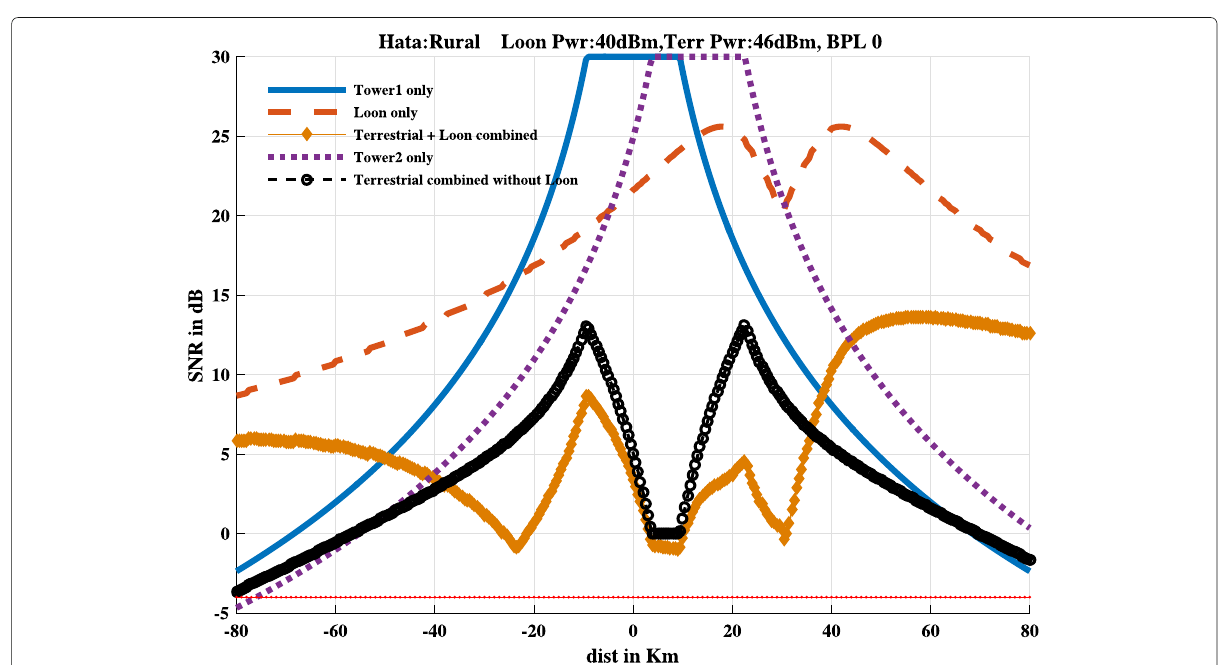
Fig. 5 Expected outdoor SINR with two rural terrestrial towers and a Loon HAP